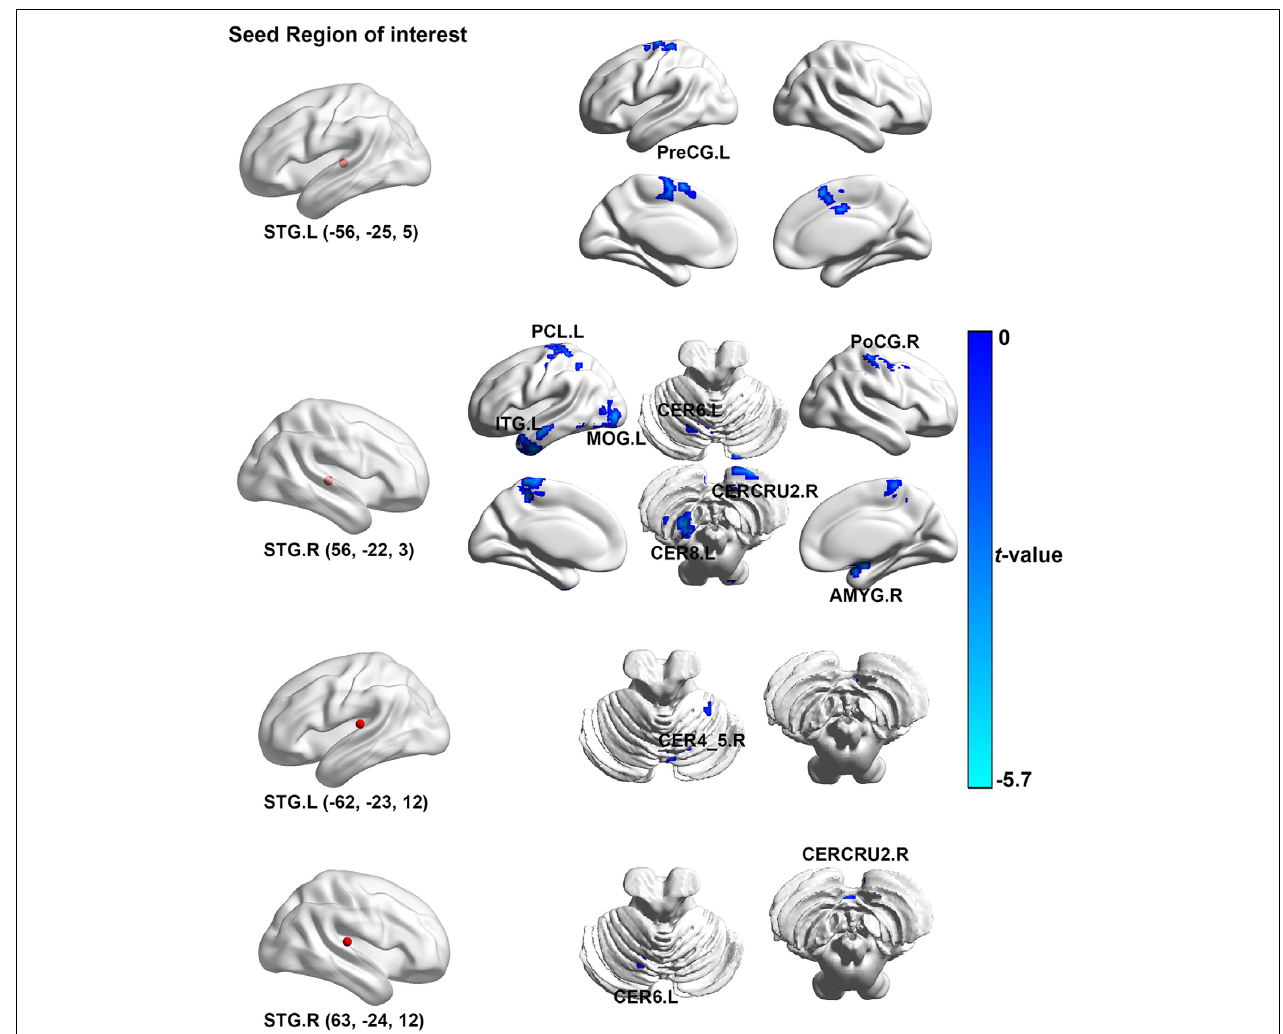
FIGURE 1 | The brain regions with significant difference in the auditory-FC between ISSNHL patients and healthy controls. Left brain diagram shows the seed region of interesting of auditory system, right brain diagram presents the regions with significant group-difference. FC, functional connectivity; STG, superior temporal gyrus; PoCG, postcentral gyrus; MOG, middle occipital gyrus; ITG, inferior temporal gyrus; PCL, paracentral lobule; AMYG, amygdala; CERCRU2, cerebellum_Crus2; CER4_5, cerebellum_4_5; CER6, cerebellum_6; CER8, cerebellum_8; L, left hemisphere; R, right hemisphere. The color bar represents the t -value. TABLE 4 | Regions showing significant differences of limbic-FC between ISSNHL patients and healthy controls. Seed region Brain regions Peak MNI coordinates x, y, z (mm) Peak T value Voxels NAc.L PoCG.R 39, − 30,